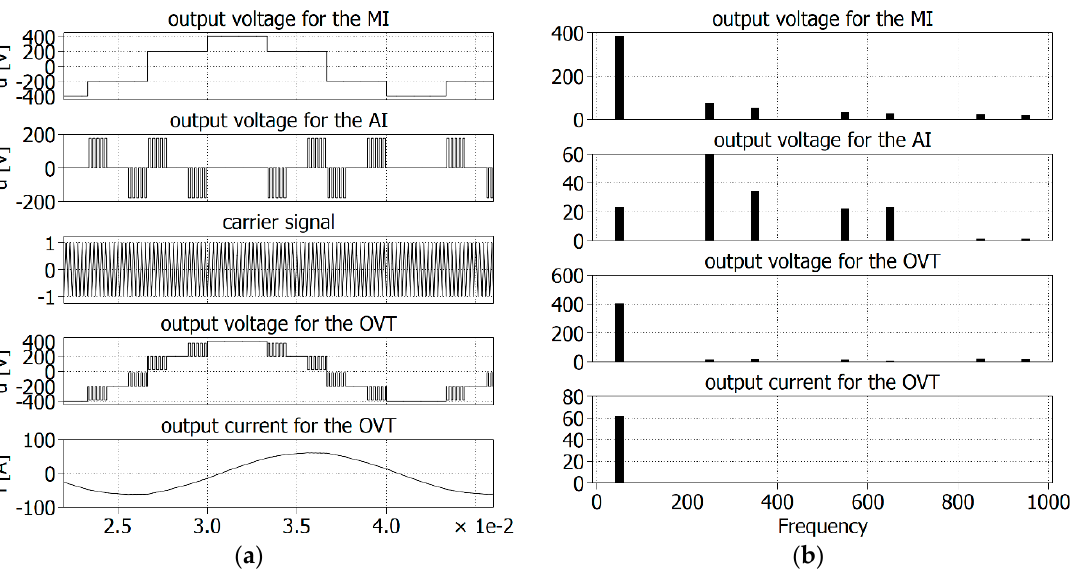
Figure 14. The voltage and current waveforms ( a ) for the OVT inverter under resistive loads and their spectra ( b ) with the use of a triangular generator.